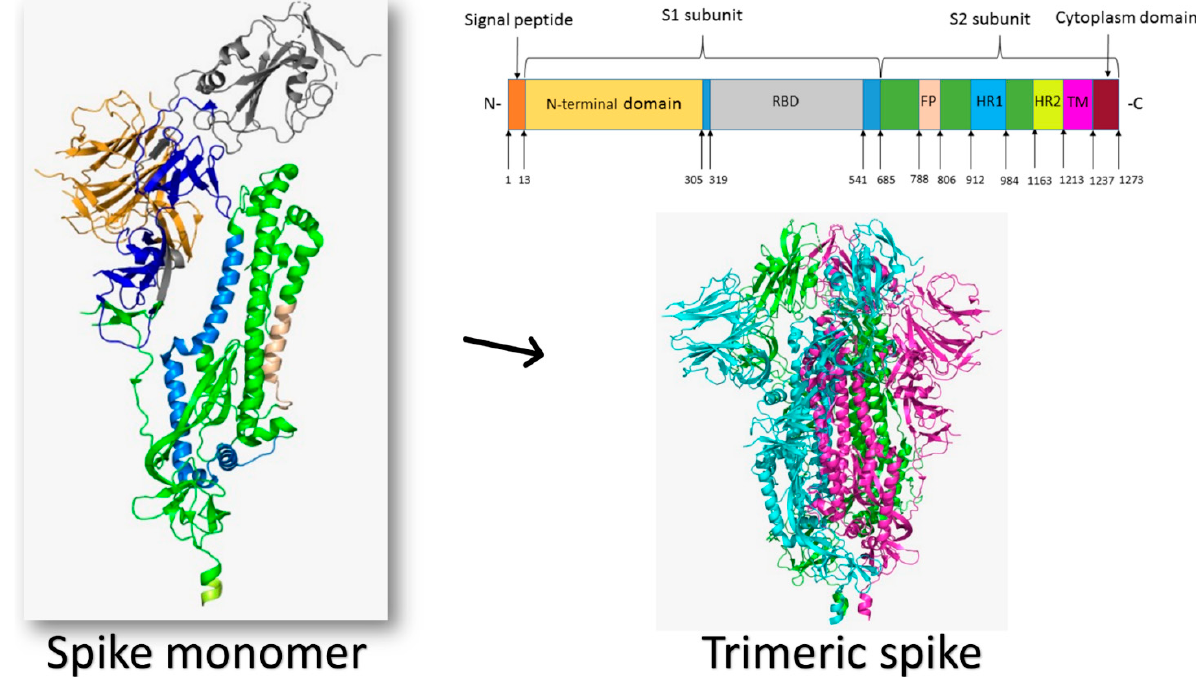
Figure 1. The structure of the SARS-CoV-2 spike protein (PDB ID: 6VXX). The monomeric spike is shown as a cartoon colored by its different domains from its N-terminus to the C-terminus. The spike protein is mono-trimeric, forming a crown-like structure over the virion.